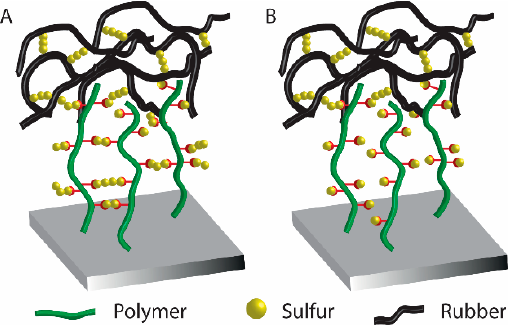
Figure 2. Illustration of ( A ) sulfide cross-linked polymer brushes and ( B ) uncross-linked thiol-containing polymer brushes both with C – S bonds to EPDM rubber, adapted from Buhl et al. [43].